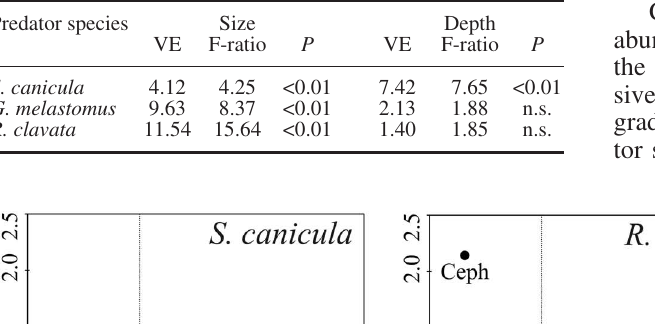
Table 3. – Results of the partial canonical correspondence analysis (pCCA) testing the effects of predator size (total length, cm) and depth (m) on the volumetric contribution of the diets of the sharks Scyliorhinus canicula and Galeus melastomus and the skate Raja clavata . The percentage of variance explained (VE), the F-ratio, and the P -value are shown (ns: non-significant effect).